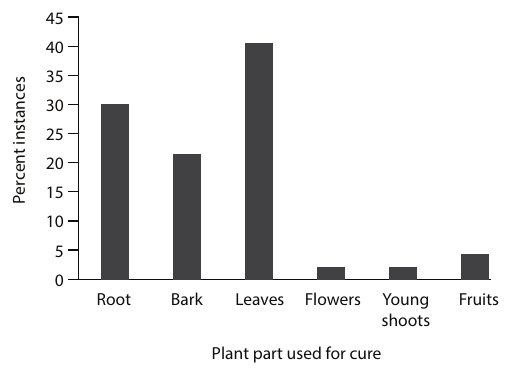
Figure 3. Percentage of use of the various parts of the medicinal plant species